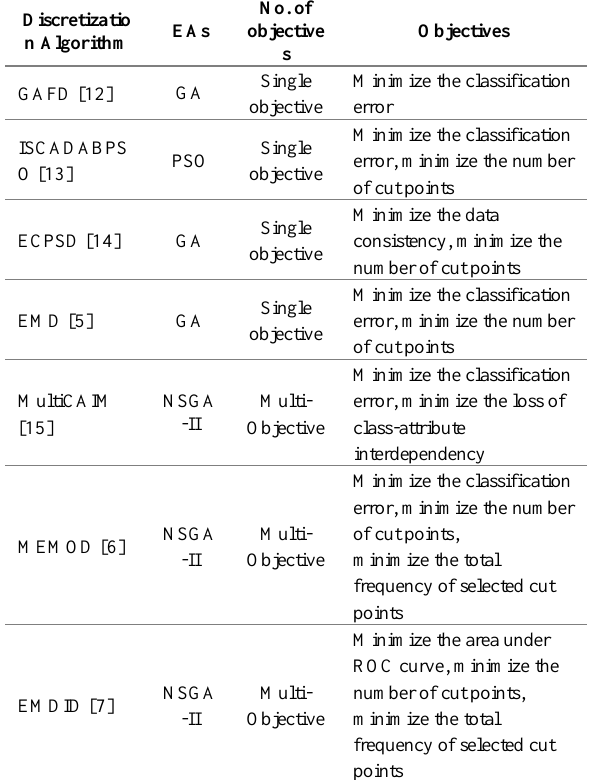
Table 1. A categorization of evolutionary discretization algorithms in the